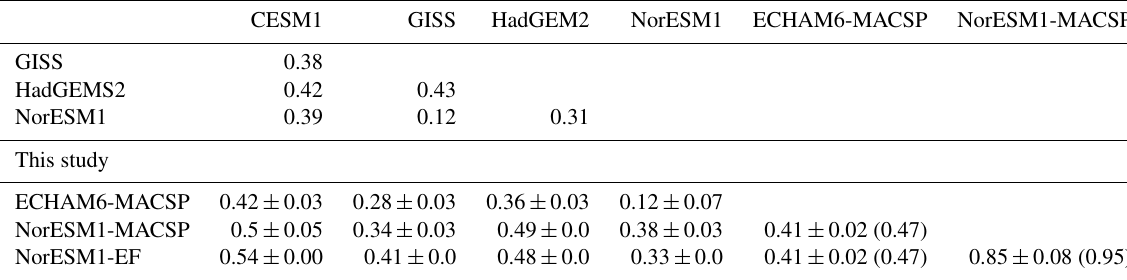
Table 4. Intermodel correlations of regional precipitation response for the Samset et al. (2018) models and our models. The average correla- tion coefficient between the models is 0 . 34 with a standard deviation of 0.10; the average correlation coefficient between the models used in this study and the Samset et al. (2018) models is 0 . 38. The correlations are calculated for 50 years with and 50 years without anthropogenic aerosols. The range of the correlation coefficient shows the standard deviations between results obtained for two different CTRL runs. The correlation for our whole dataset (60 + 120 years) is shown in